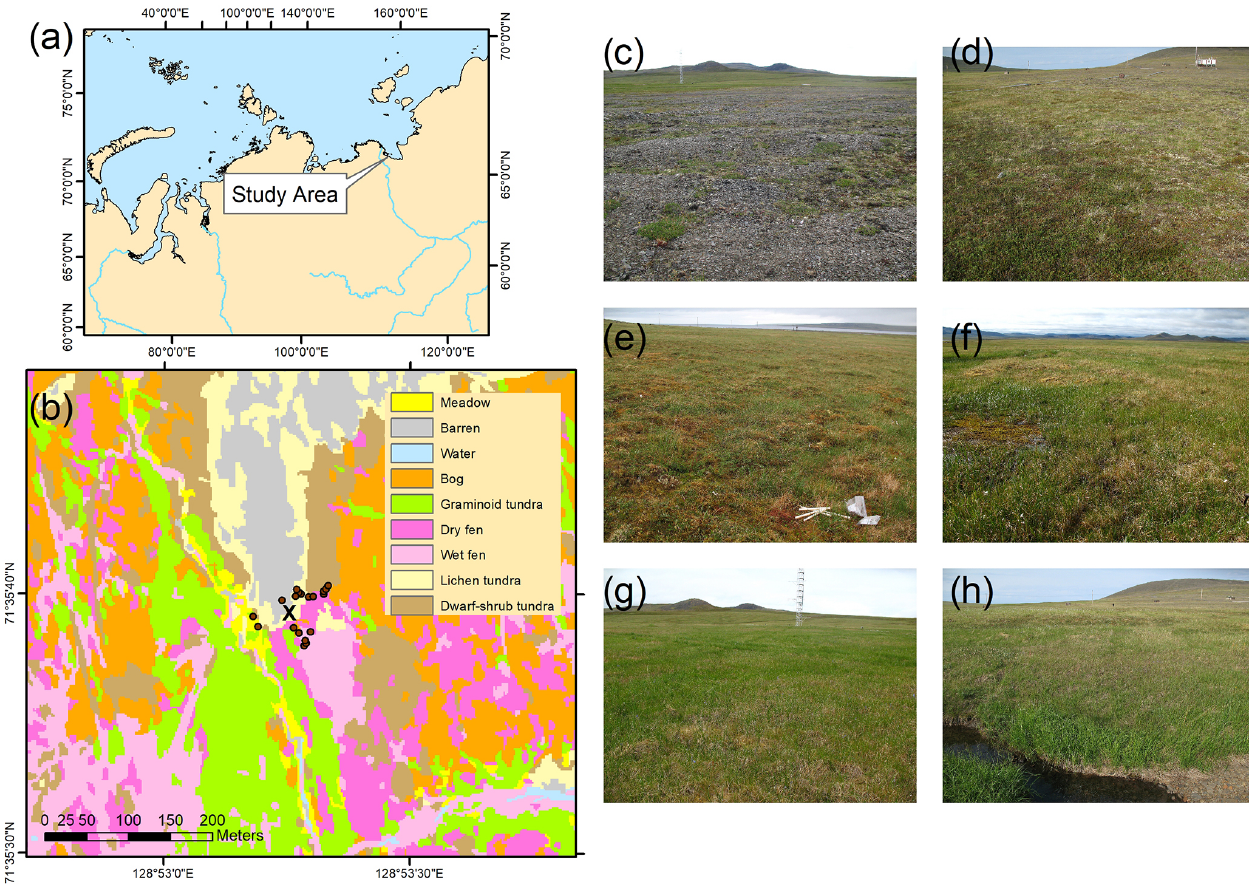
Figure 1. (a) Location of the study area in Tiksi, Yakutia, Russia. (b) Land cover map with the chamber flux measurement points (dark dots) and the EC mast (cross), and photos of the land cover types: (c) lichen tundra with barren ground and patches of vegetation, (d) dwarf-shrub tundra, (e) bog, (f) wet and dry fen, (g) graminoid tundra, and (h) meadow by the stream. See Tuovinen et al. (2019) for the EC footprint